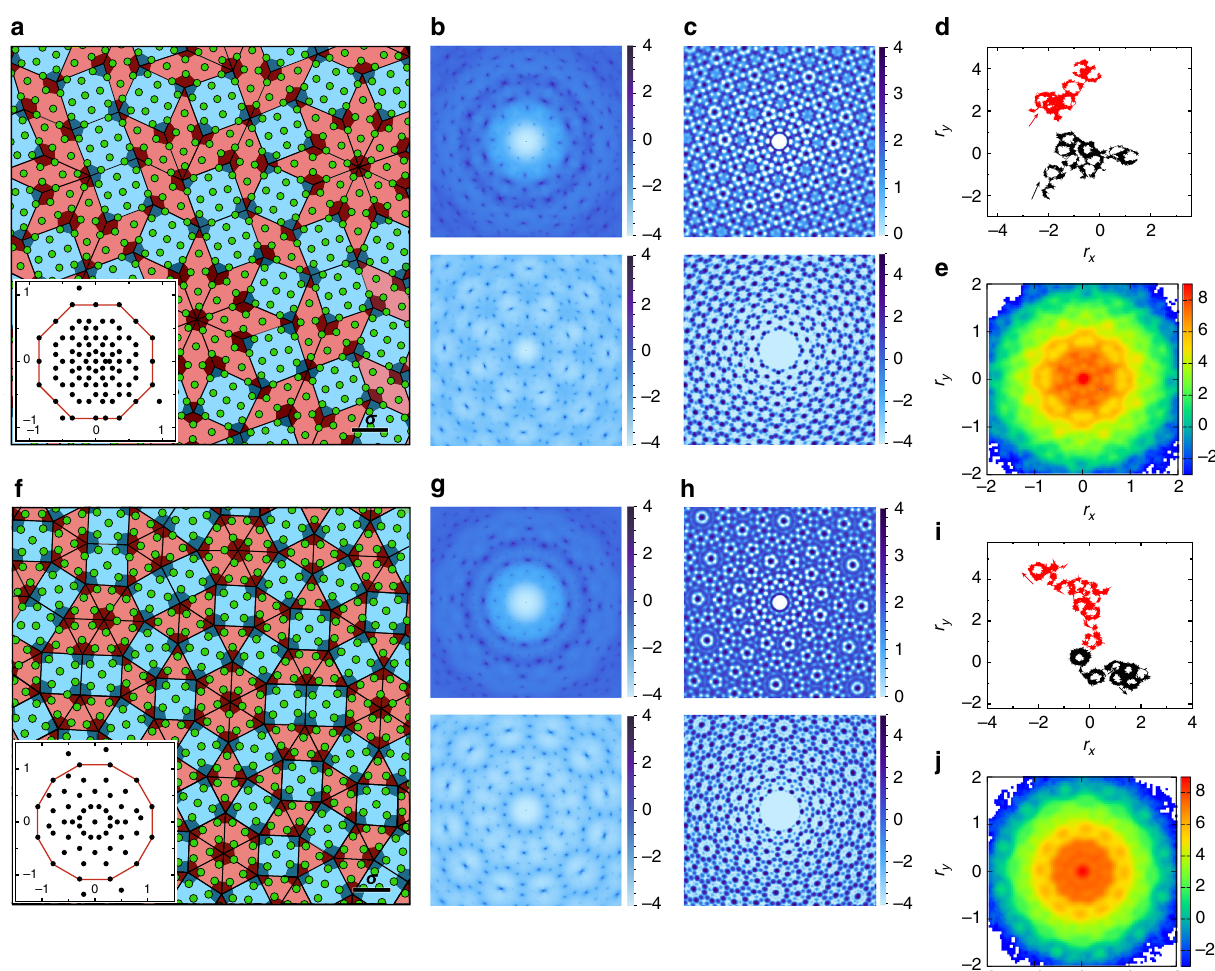
Fig. 2 Characterization of the structure and dynamics of two types of quasicrystals. a – e and f – j are for an OQC and a DDQC at ( ρ , α , T ) = (6.6, 2.0, 1.36 × 10 − 3 ) and (7.0, 2.0, 1.72 × 10 − 3 ), respectively. a , f A part of static con fi guration with the square – rhombus (square – triangle) tiling. The black scale bar indicates the actual size of particle diameter σ . Note that the shaded pentagons prevail, whose centers are connected to construct the tessellation. The inset shows the projection of the QC in the perpendicular space with the red polygon being the atomic surface. b , c , g , h Diffraction patterns and density pro fi les calculated from single particles (top panel) and from pentagons (bottom panel). d , i Particle trajectories during a time interval of 10 5 with the arrows pointing to the original direction of motion. e , j van Hove autocorrelation function G a ( r , t ) at t = 6000. The values of the scale bars are in the